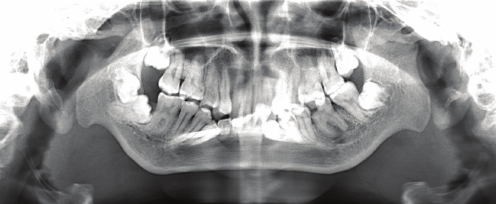
Figure 5: OPG shows condylar aplasia on the right side, condy- lar hypoplasia on the left side, prominent antigonial notch, and hypoplasia of